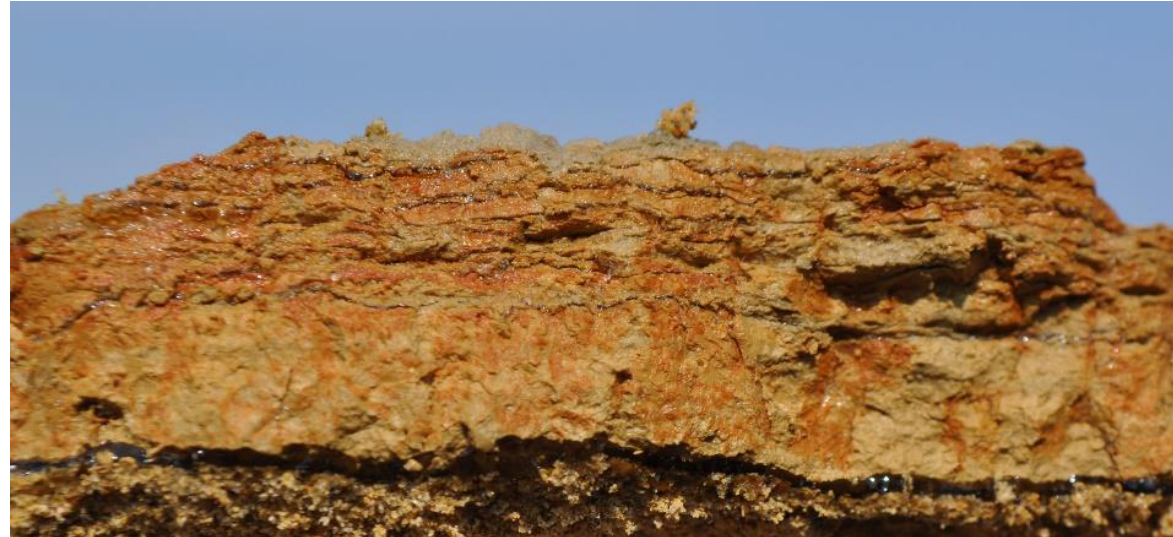
Figure 3. A fragment of the substance of Shakhtama tailings from a pit with a depth of 44 – 54 cm with ice inclusions.